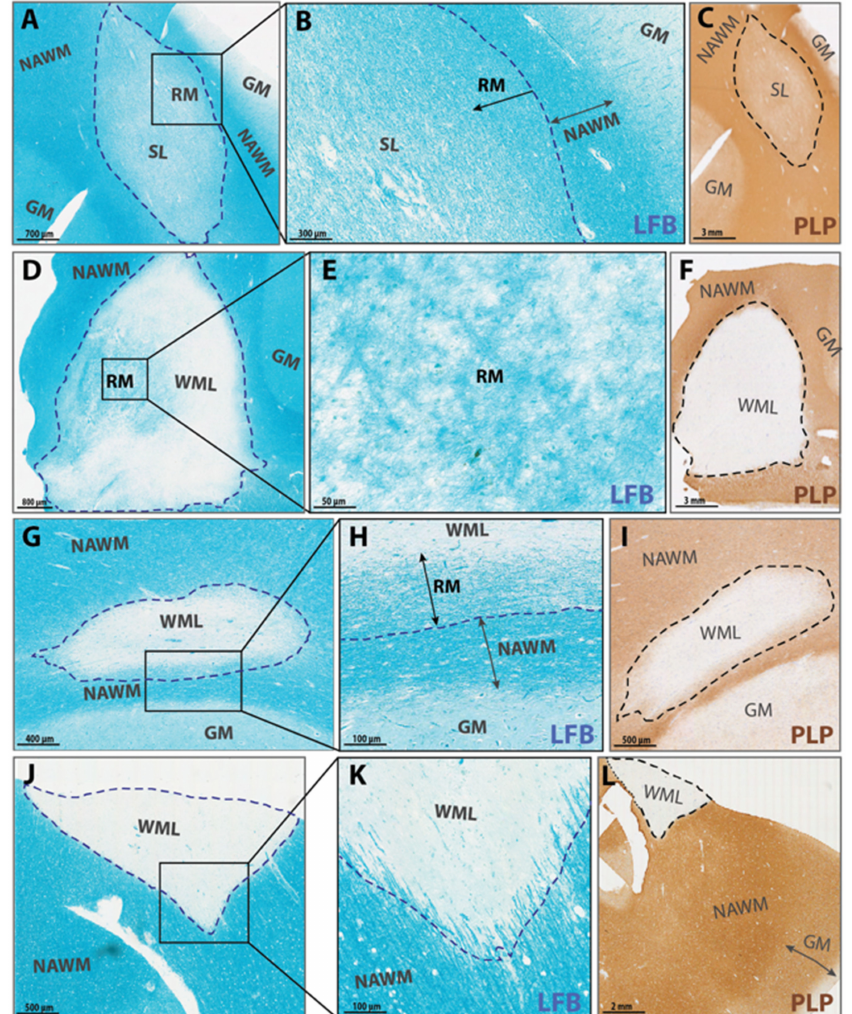
Figure 5. LFB (blue) stained WM Lesions with remyelination score 3, 2, 1, 0, respectively ( A – L ). [19,20,22] ( A – C ) represent a shadow lesion (SL, remyelination score 3). ( A ) showing an almost completely remyelinated SL, covering almost the entire surface, but still with lower myelin density in the center. Fibers are running almost similar to the fibers of adjacent NAWM. ( B ) The lesion border is still visible, with a visible gradient in myelin density (indicated by arrows). ( D – F ) Lesion with substantial remyelination (remyelination score 2), with thin, patchy myelin fibers spread throughout the lesion area ( E ). ( G – I ) Lesion with partial remyelination (remyelination score 1), showing a thinner myelin gradient restricted to the lesion rim (indicated by the arrow in ( H )). ( J – L ) Demyelinated lesion (remyelination score 0) with at the border normal myelin thickness and cut in the same fiber direction as the surrounding NAWM. ( C , F , I , L ) Corresponding immunohistochemical myelin staining (PLP; brown) showing NAWM, WML, GM and